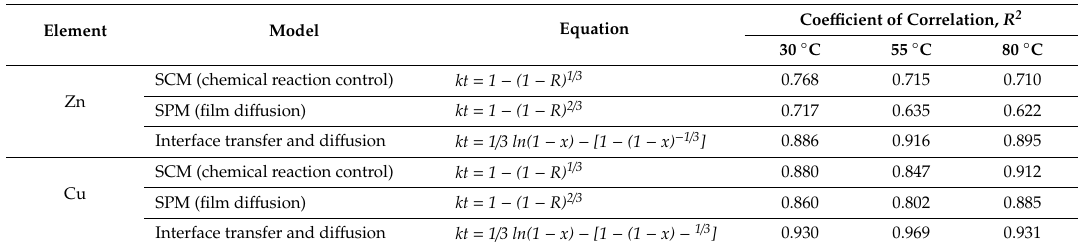
Table 5. Correlation coe ffi cient for experimental data fitting using three kinetic models (SCM, shrinking core model; SPM, shrinking particle model).